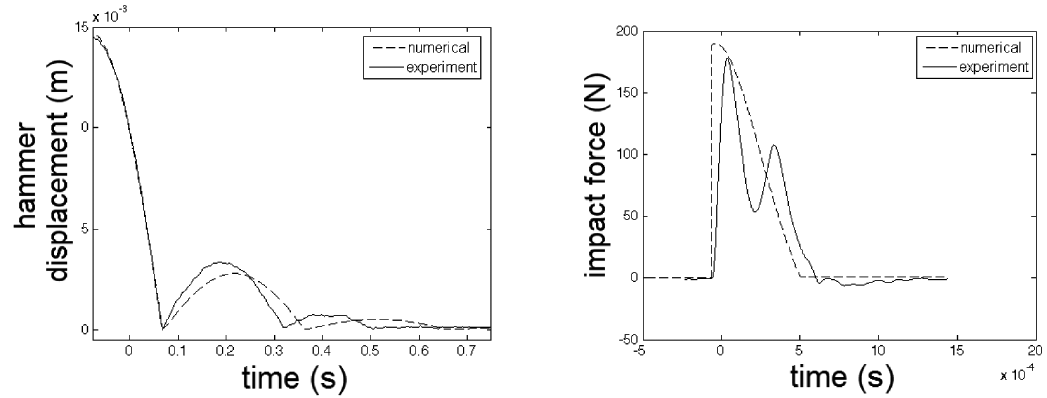
Fig. 10. Impact force parameters identi fi cation, spring-dashpot model. Comparison between experimental data and numerical simulation.